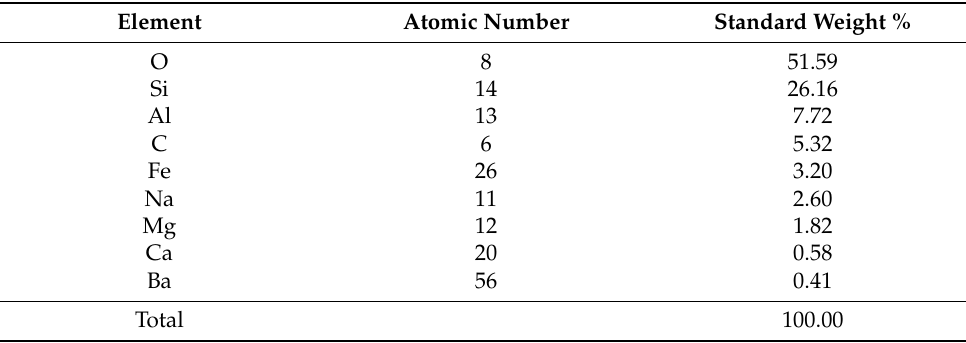
Figure 5. Spectrum obtained by microanalysis of X-rays characterized by EDS. Table 5. Elements analyzed by